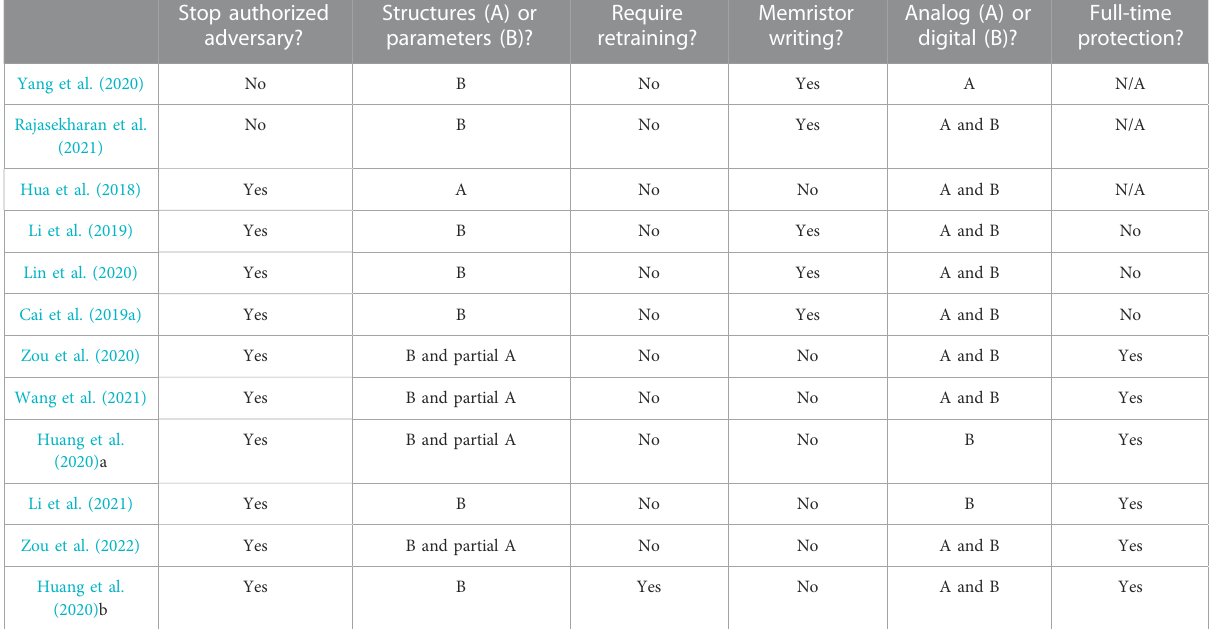
TABLE 1 Cross-comparison of the security